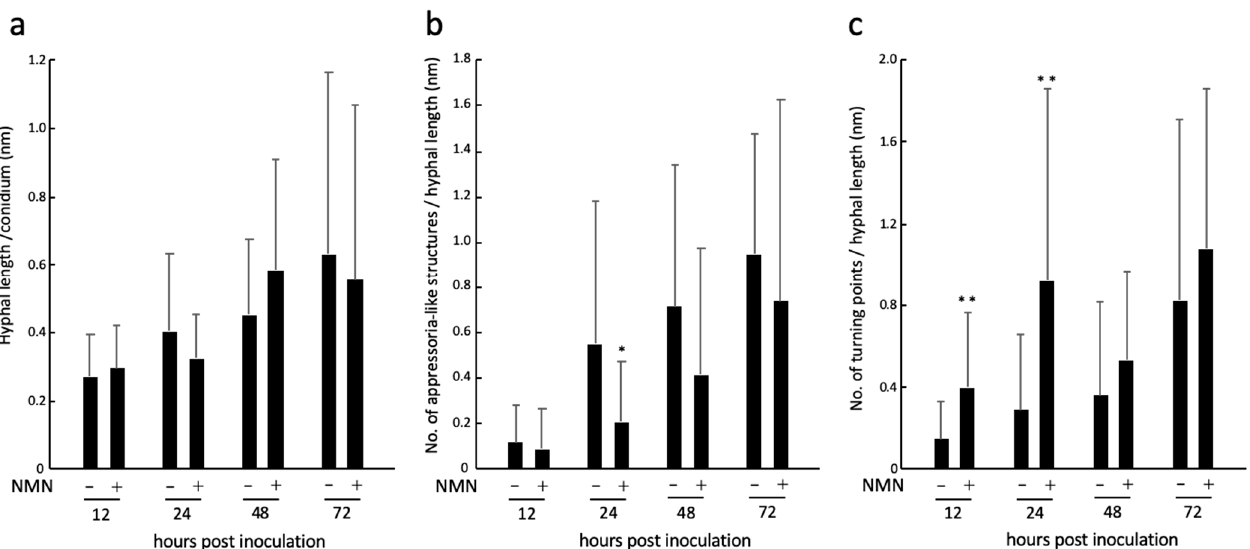
Figure 4. Morphology of Fusarium graminearum on coleoptile epidermal cells treated with 500 ppm NMN. ( a ) The hyphal length of F. graminearum. ( b ) The appressoria-like structures per hyphal length. The asterisk indicates a significant difference between control and NMN treatments ( p < 0.05; Student’s t-test). ( c ) The turning points per hyphal length. The double- asterisk indicates a significant difference between control and NMN treatments ( p < 0.01; Student’s t-test). Bars indicate the standard deviation ( n = 24).